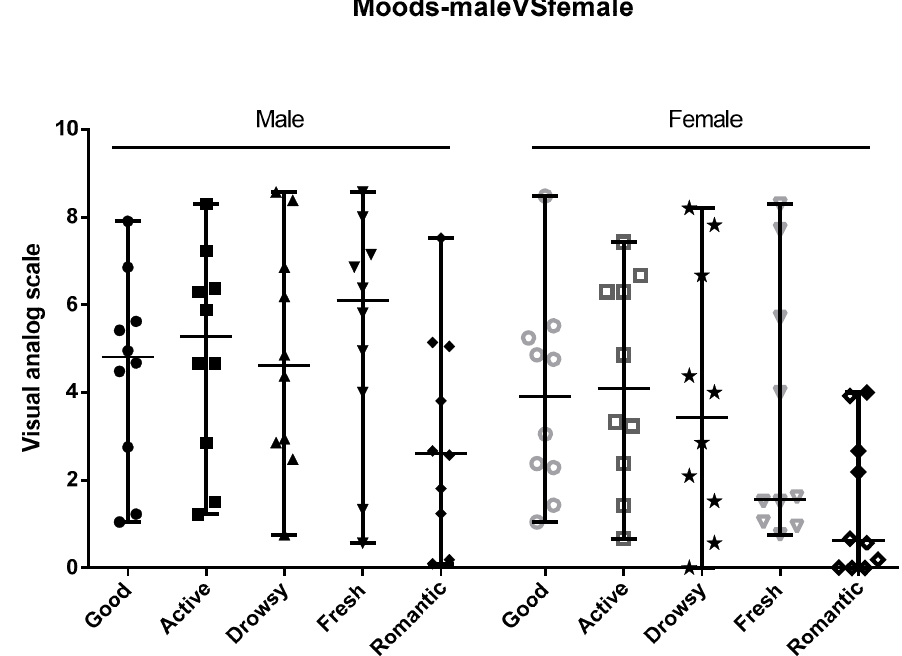
Figure 5. Moods and brain arousal states of male and female subject evaluated by a visual analog scale. Each mood and feeling were expressed in different symbols.